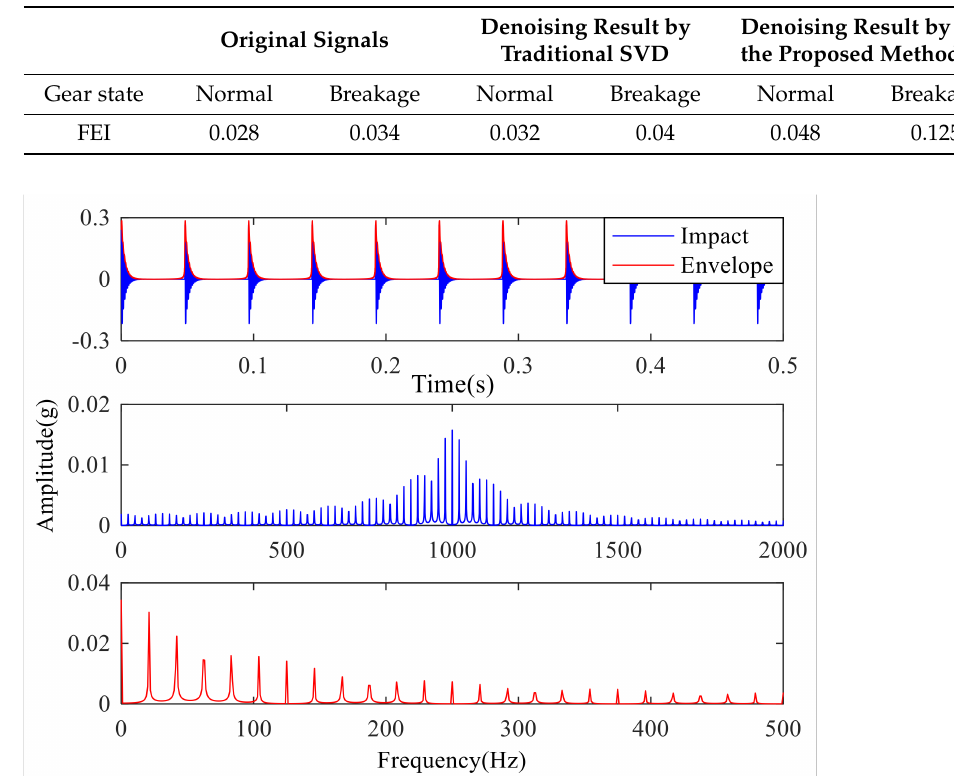
Figure 20. Envelope demodulation of fault